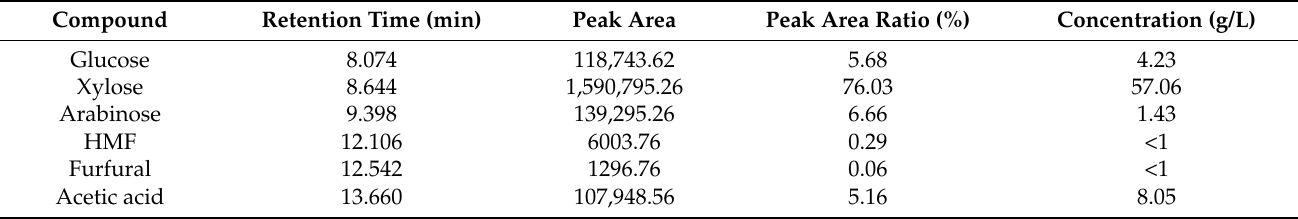
Table 2. Main HPLC detection indexes of the hydrolysate provided by Huakang